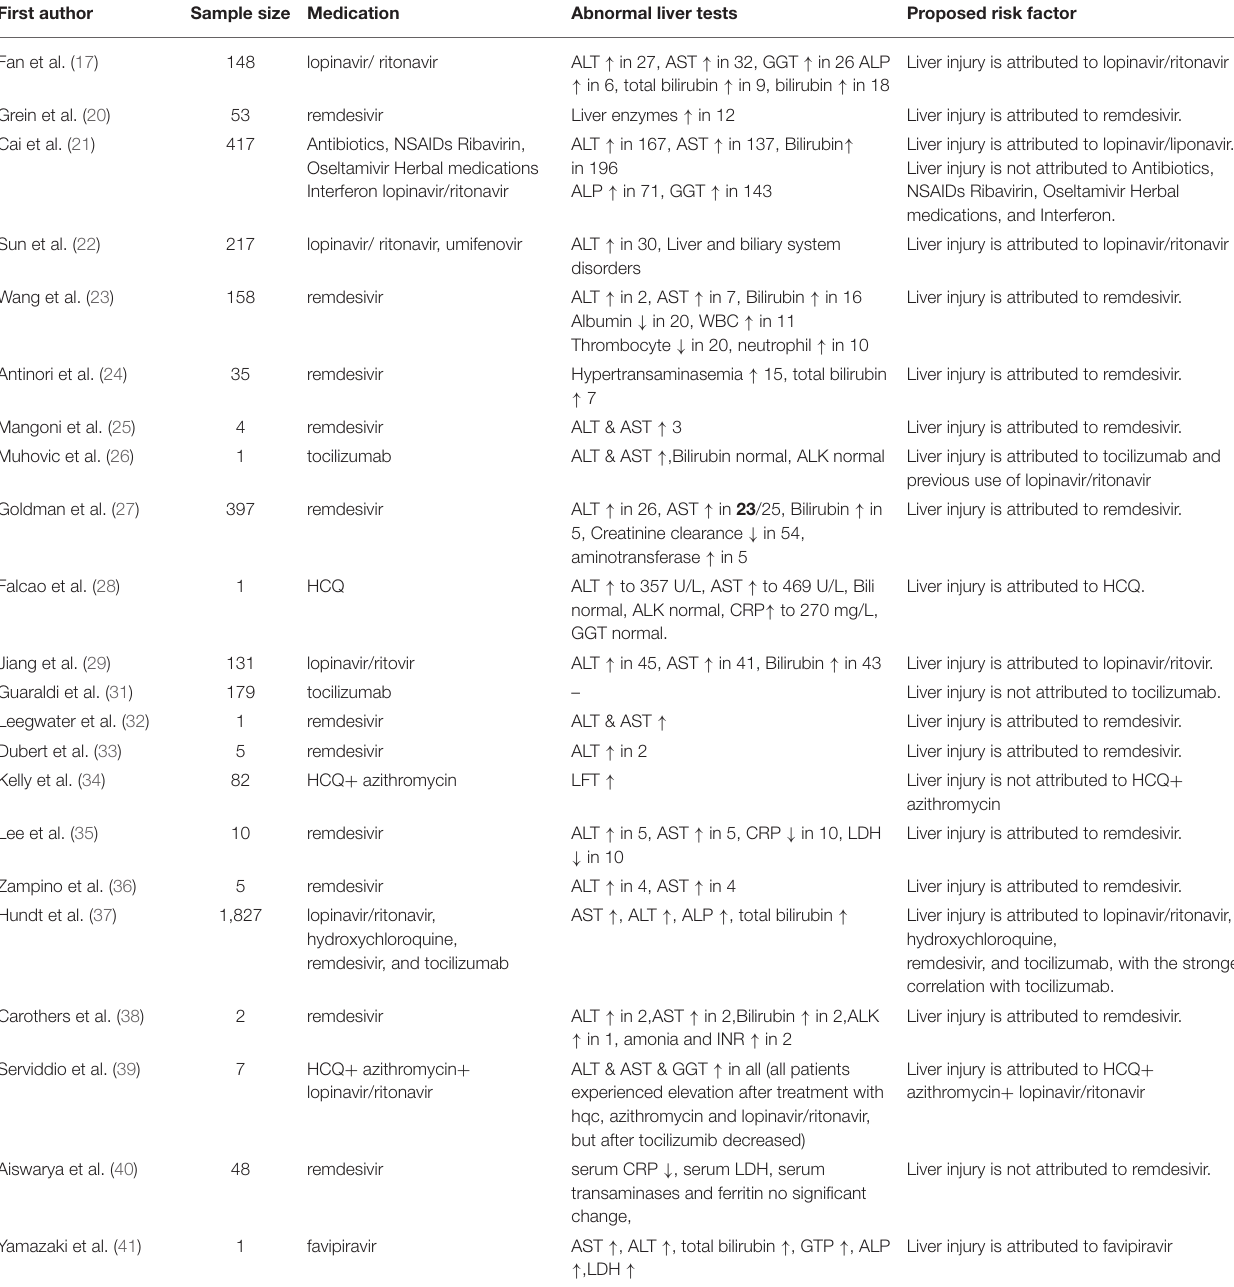
TABLE 2 | Effect of drugs on liver function